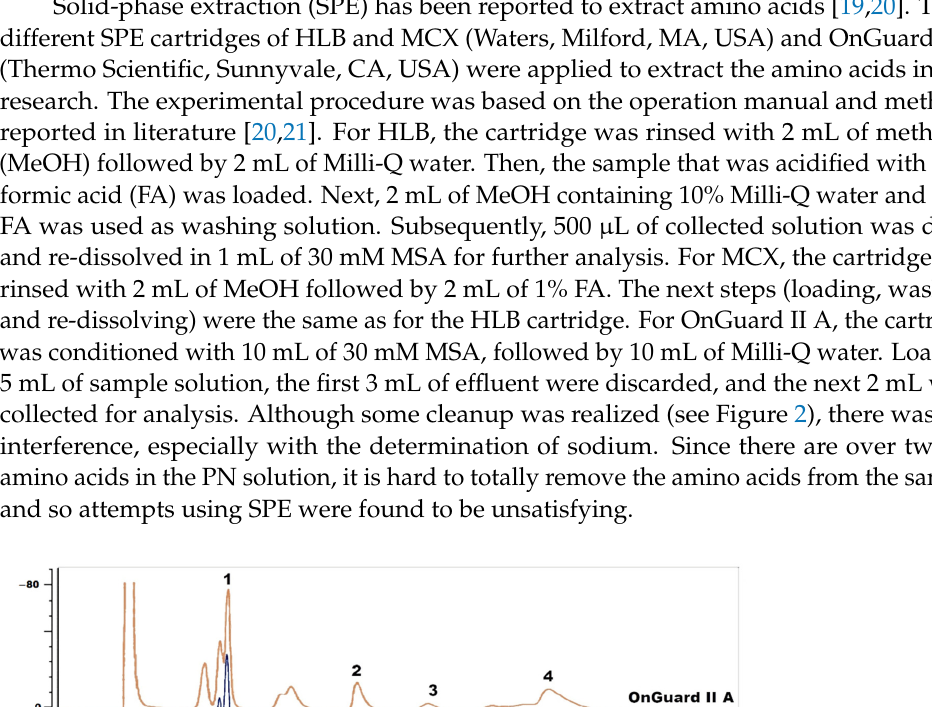
Figure 1 . Chromatogram of blank, standard solution of cations in the PN solution, mixture of amino acids and PN solution without pretreatment. Peak 1: sodium, peak 2: potassium, peak 3: magnesium and peak 4: calcium.